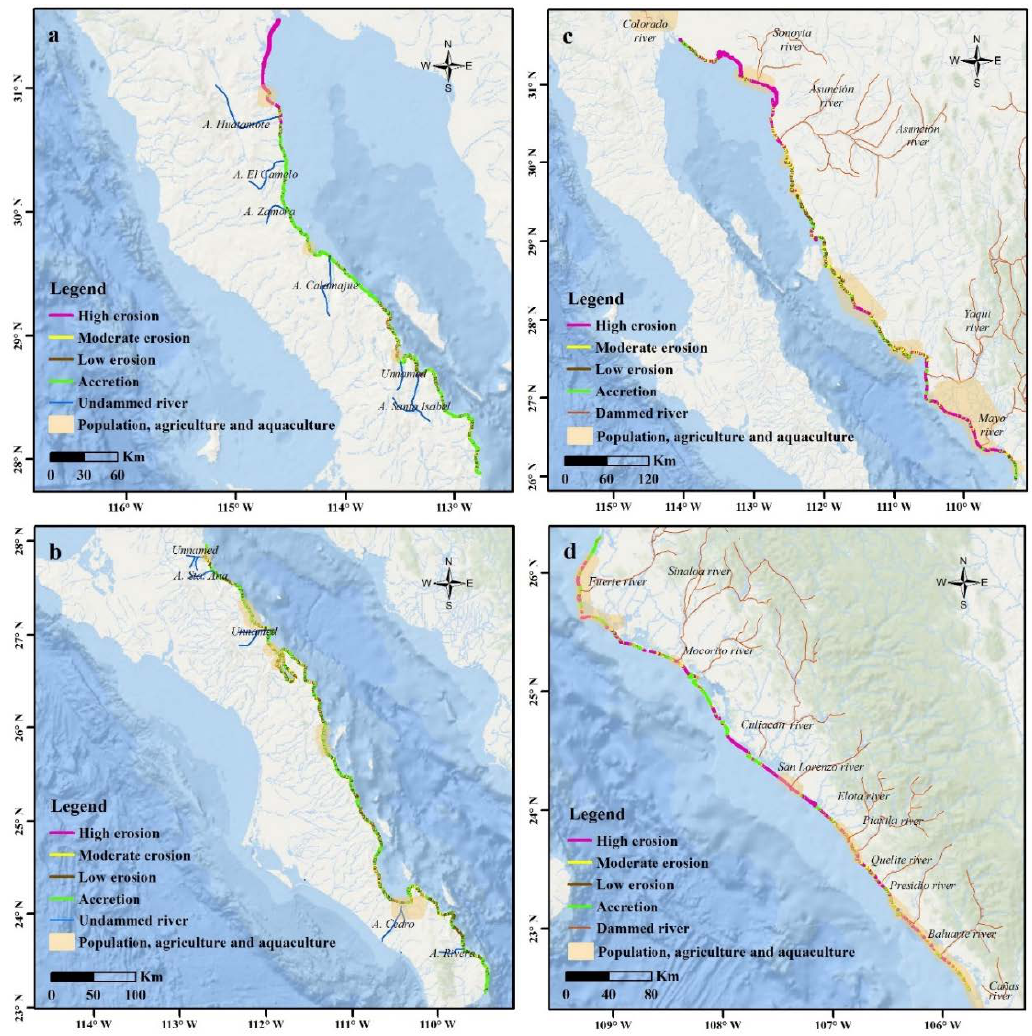
Figure 4. Long-term shoreline change maps: ( a ) B.C.; ( b ) B.C.S.; ( c ) Sonora; ( d ) Sinaloa.